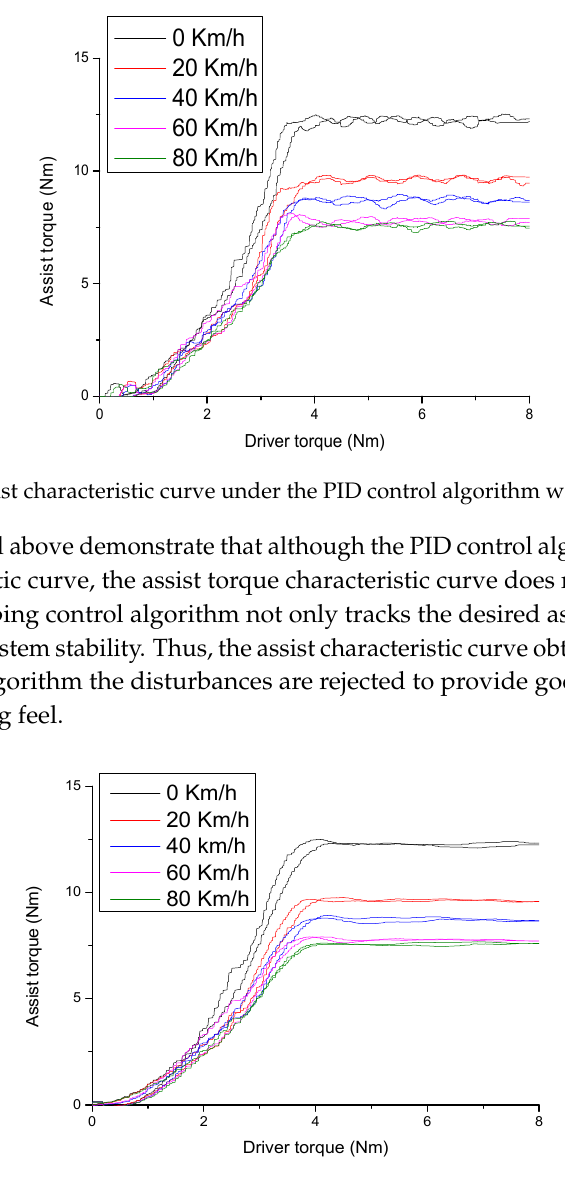
Figure 33. Actual assist characteristic curve using the proposed loop-shaping control algorithm with different velocities.